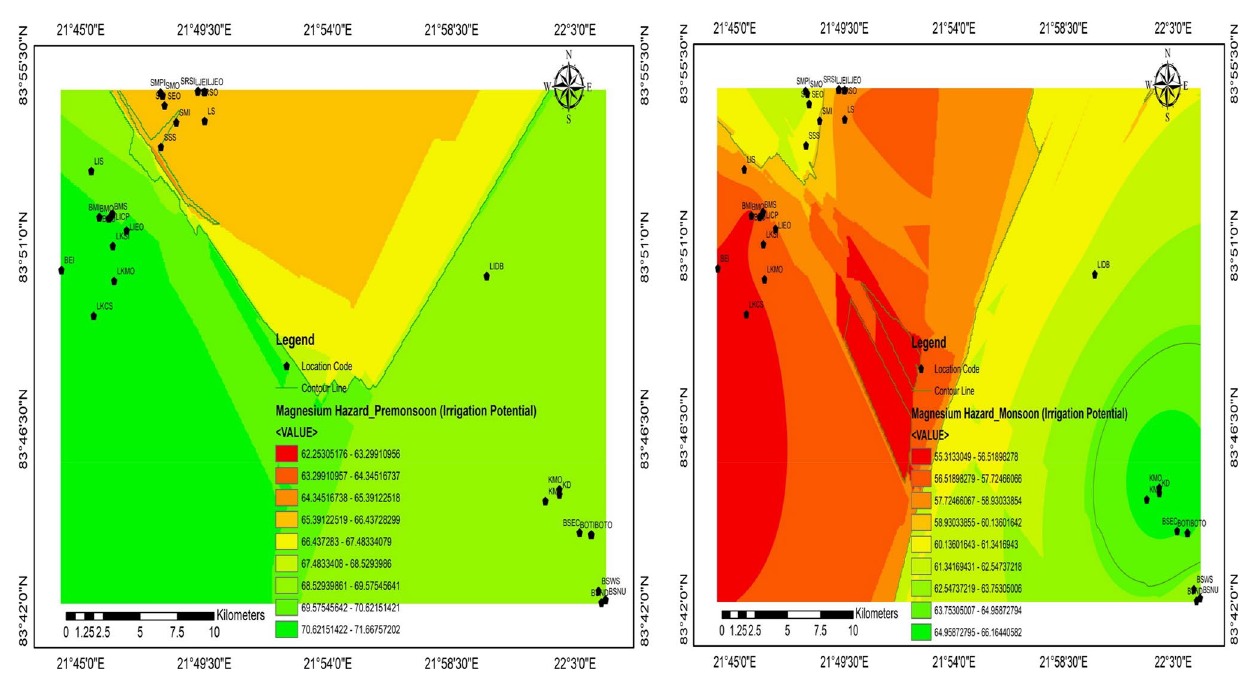
Fig. 15 Contour map of Magnesium Hazard in water samples during premonsoon and monsoon